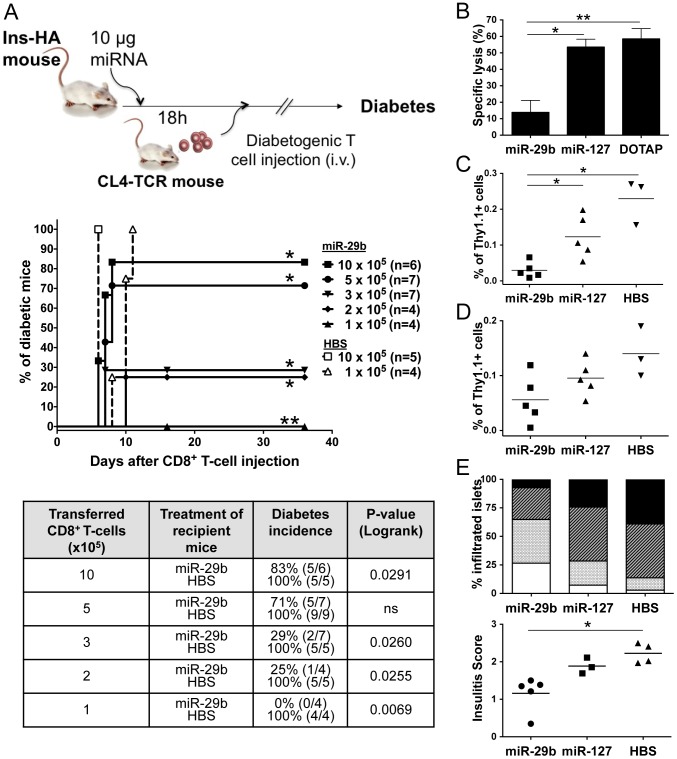
Systemic delivery of miR-29b protects against adoptive transfer of T1D in vivo.Ins-HA mice were treated intravenously with miR-29b, miR-127, HBS buffer or DOTAP alone, eighteen hours before receiving HA-specific CTLs from CL4-TCR mice. (A) Recipients were monitored for diabetes development for at least one month. The survival curves and table summarize the results of five independent experiments after transfer of 1 to 10×105 cells, with miR-29b -injected mice as filled symbols, and HBS-injected mice as empty symbols. The table indicates, for each group, the percentage of final cumulative diabetes incidence and the number of diabetic mice among all mice in the group in brackets. A logrank test was performed for statistical significance of differences between Kaplan-Meier incidence curves. (B) Eighteen hours after miRNA injection, Ins-HA recipient mice received 5×105 activated HA-specific CTLs, followed 48 h later by the intravenous administration of HA-pulsed «CFSEhigh » and non-pulsed «CFSElow » target cells mixed at a 1∶1 ratio. Splenocytes from recipient Ins-HA mice were analysed by flow cytometry, sixteen hours after target cell injection. The bar chart shows the compiled results of three independent experiments (n = 4–5 mice/group) as mean specific lysis ± SEM. *P<0.05, **P<0.01 (Mann-Whitney). (C–E) Eighteen hours after miRNA injection, Ins-HA were transferred with 8×105 activated HA-specific Thy1.1+ CTLs from CL4-TCR+Thy1.1+ mice. Four days later, spleens (C) and PLNs (D) were harvested from Ins-HA recipient mice and analysed by flow cytometry. Compiled results of two independent experiments are presented as the percentage of Thy1.1+ cells in individual mice gated on the CD3+ CD8+ T-cell population (n = 3–5 mice), and were confirmed in a third experiment. *P<0.05 (Mann-Whitney). (E) Histological analysis of insulitis of pancreata: 0 = islet free of mononuclear cell infiltration (unfilled bars); 1 = peri-insular infiltration involving <10% of the islet area (punctuated bars); 2 = infiltration involving between 10% and 50% of the islet area (hatched bars); 3 = infiltration involving >50% of the islet area (black bars). The stacked vertical bar graph indicates the percentage of islets in each category described above. Results are presented as the mean percentage of n = 5 mice for miR-29b, n = 3 for miR-127, and n = 4 mice in the HBS group from three independent experiments. For each pancreas, an average insulitis score was calculated by adding up the score of each islet and dividing it by the total number of islets counted. Results show the individual insulitis scores for each group of recipient mice. *P<0.05 (Kruskal-Wallis).